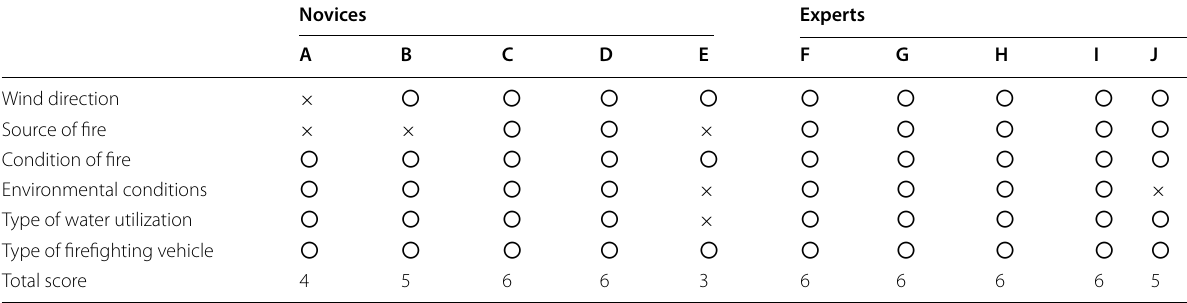
Table 12 Result of the evaluation items for deciding on the water discharge point Novices